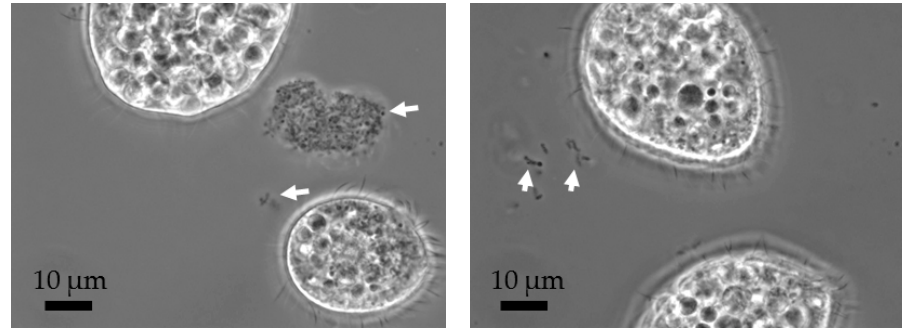
Figure 4. Representative phase contrast images of the pelleted fraction after centrifugation of T. thermophila suspensions through 10% iodixanol. The two images serve as replicates and are both shown since bacterial agglomerates ( left image) and free bacterial cells ( right image) were each observed. White arrows indicate bacterial agglomerates or cells that pelleted with the protozoan cells.